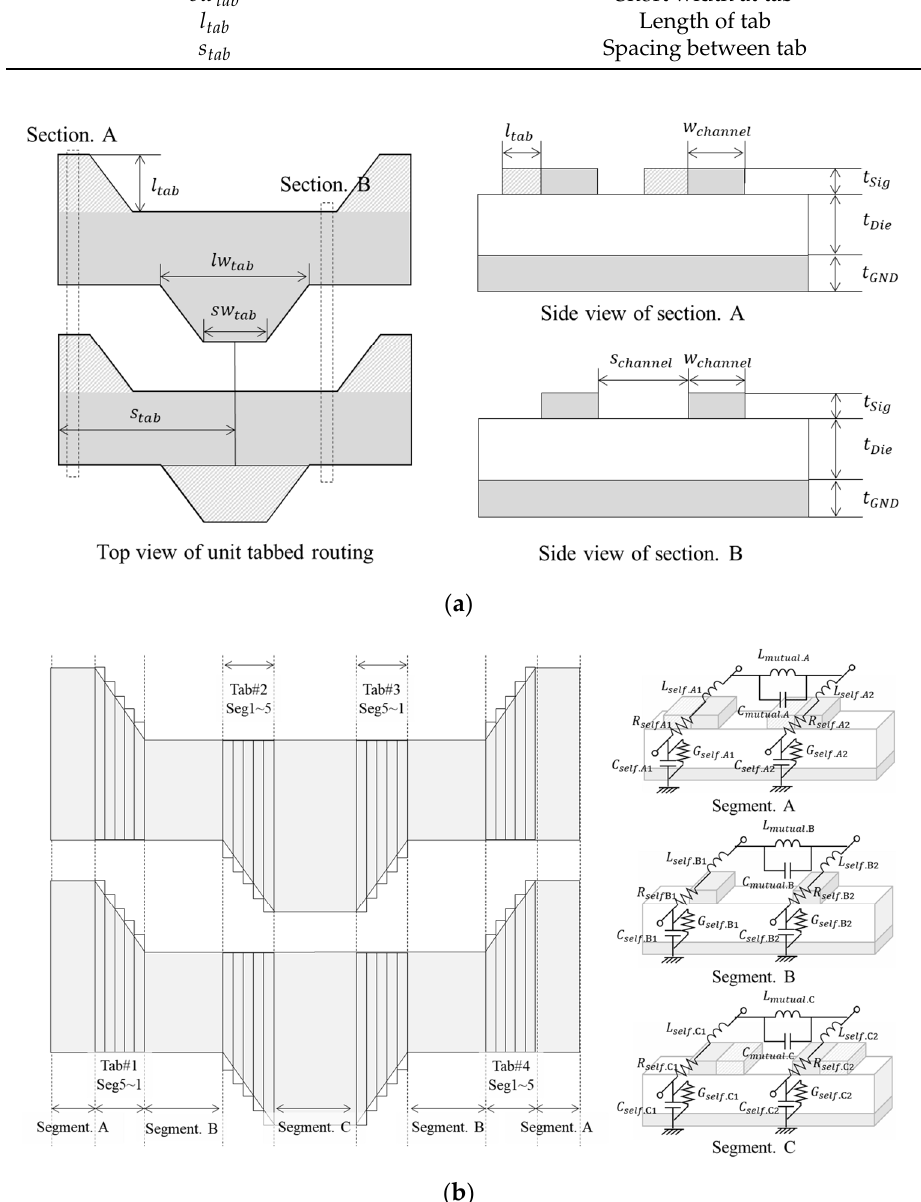
Figure 3. ( a ) Top and side views of one-unit tabbed routing with the structural parameters. In contrast with the normal transmission line, tabbed routing is required to be modeled by a one-unit tab for signal integrity characteristics. ( b ) Conceptual image of the segmentation method for modeling of tabbed routing with the RLGC equivalent circuit model. Each segment is constructed as asymmetrical coupled micro-strip lines with different channel widths.